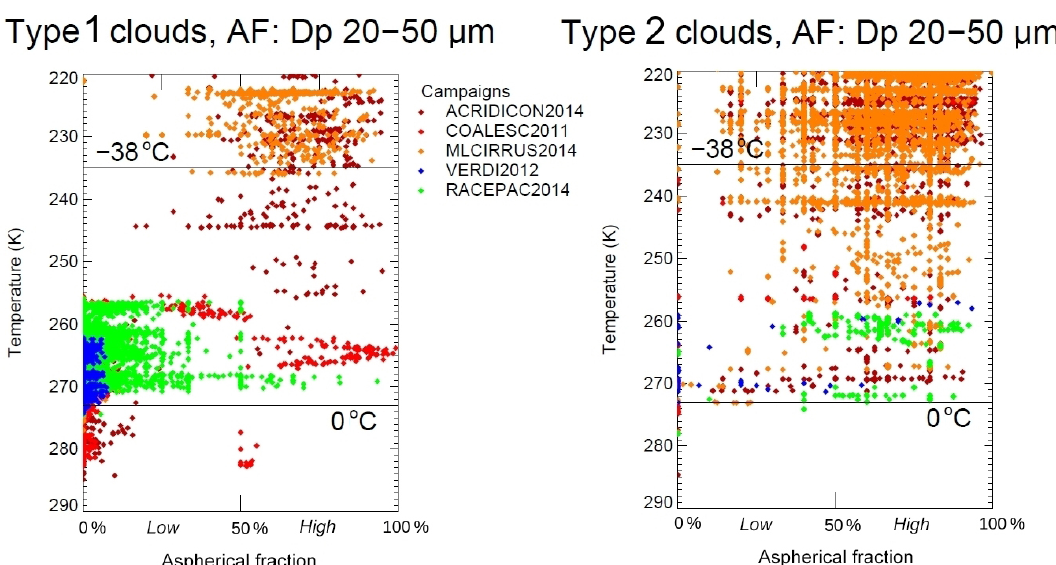
Figure 11. Aspherical fractions (AFs) for D p =20 to 50µm. Type 1 clouds show a variety of AF. Type 2 shows AFs comparable to cirrus clouds – which is illustrated by observations from the ML-Cirrus campaign – throughout the temperature range.